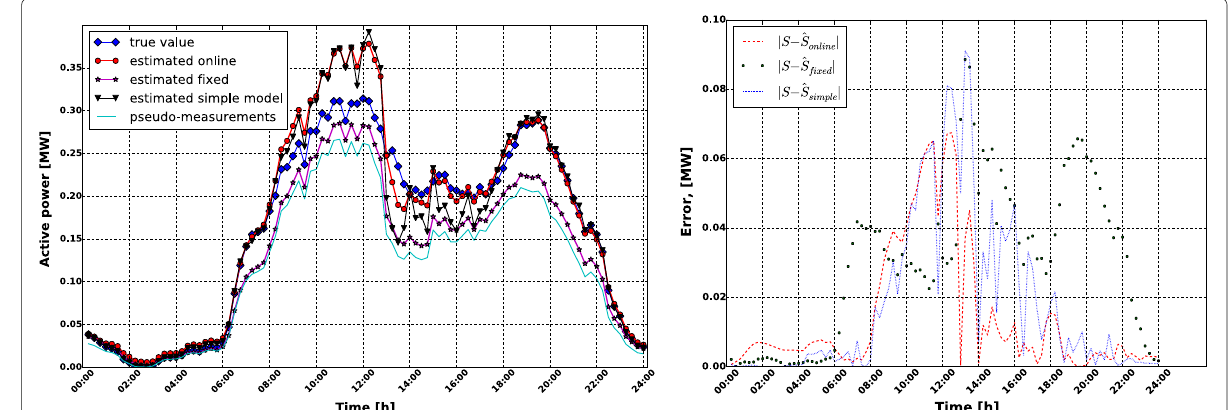
Fig. 3 Left: power estimation using the NLO with the proposed online learning technique, using the NLO with fixed ARMA(2,0) parameters and the (simulated) true values and pseudo-measurements considered. Right: error between true values of power and estimated with three models: simple model, ARMA(2,0) model with fixed parameters, and ARMA(2,0) with online learning